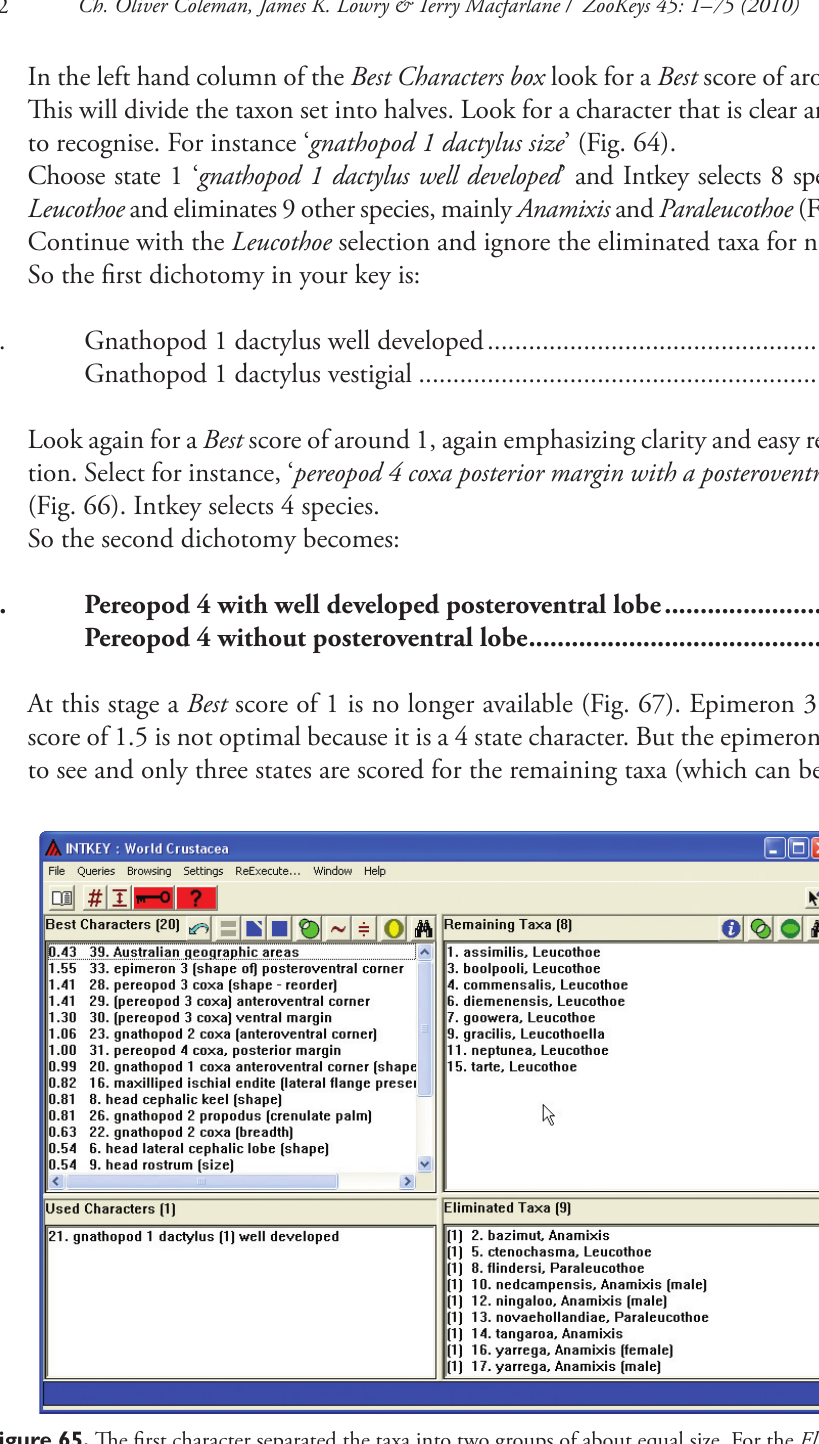
Figure 65. Th e fi rst character separated the taxa into two groups of about equal size. For the Eliminated Taxa the selected character state did not